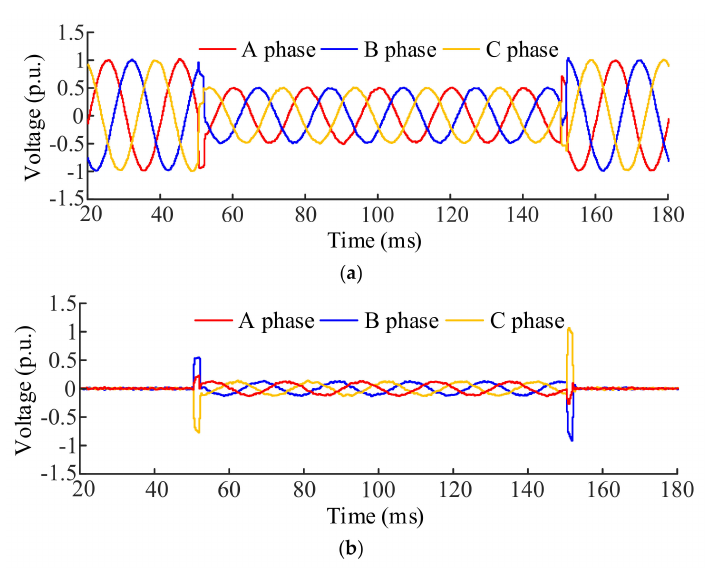
Figure 11. The extraction of positive-sequence and negative-sequence voltage component; ( a ) positive- sequence voltage component; ( b ) negative-sequence voltage component.